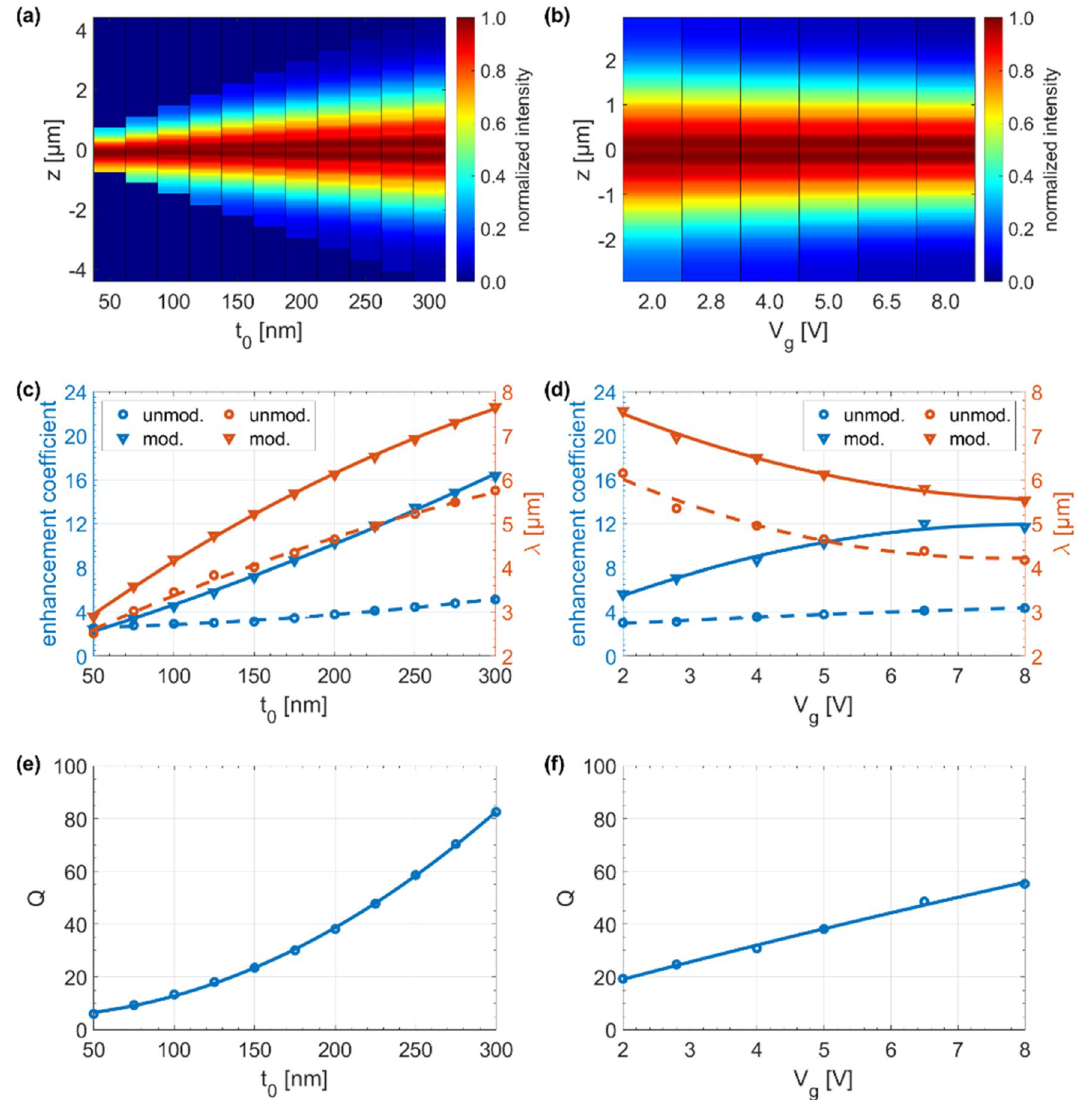
resonance enhancement coefficient as a function of ( c ) base dielectric thickness and ( d ) applied gate voltage; hyperbolic microcavity Q-factor as a function of ( e ) base dielectric thickness and ( f ) applied gate voltage. All curves are quadratic polynomial fits to the